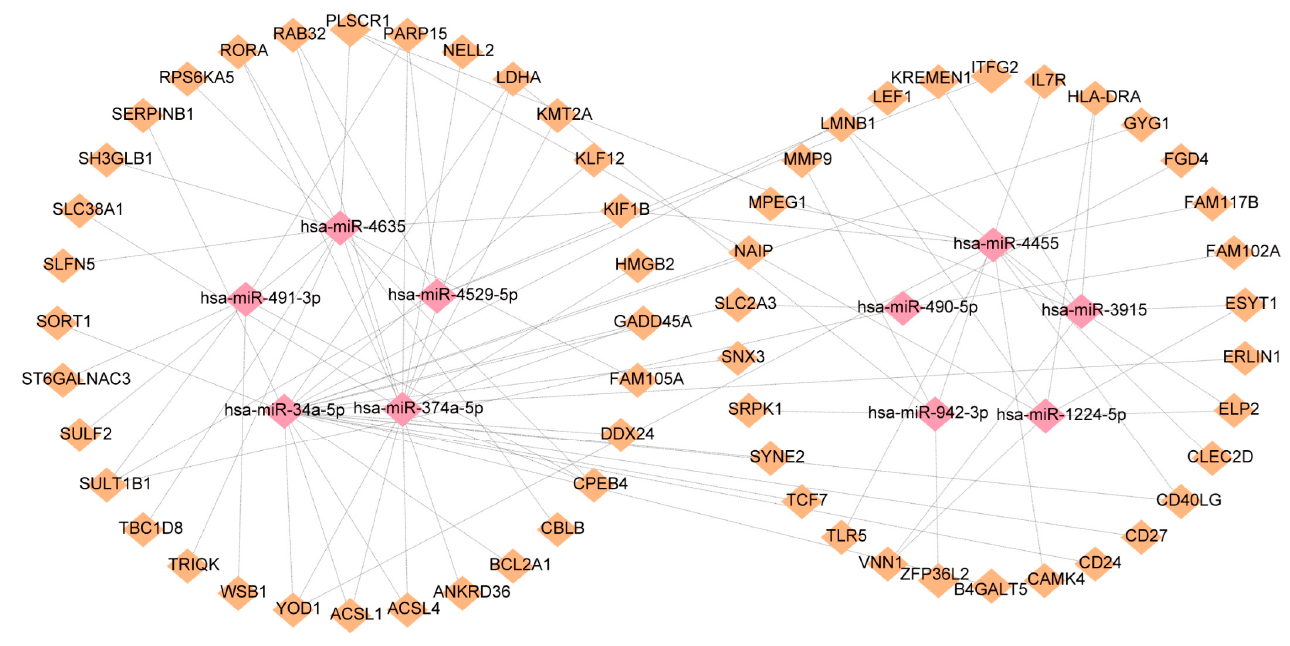
Figure 7. DEGs and miRNAs interact to regulate gene expression. The miRNAs are represented by pink diamond patterns and DEGs are represented by orange diamonds.